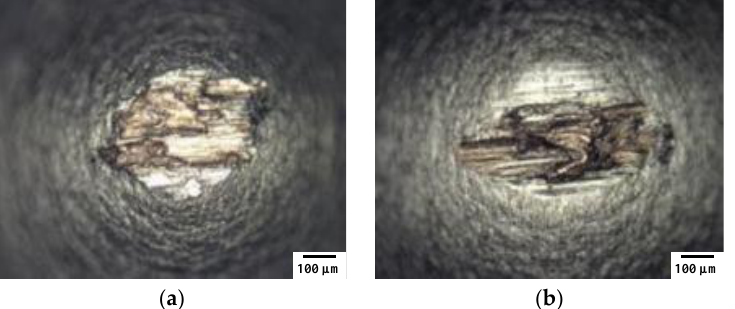
Figure 13. Micrographs of the worn surface for the embossed specimens corresponding to the experimental data in Figure 12: ( a ) Experiment 1 and ( b ) Experiment 2.